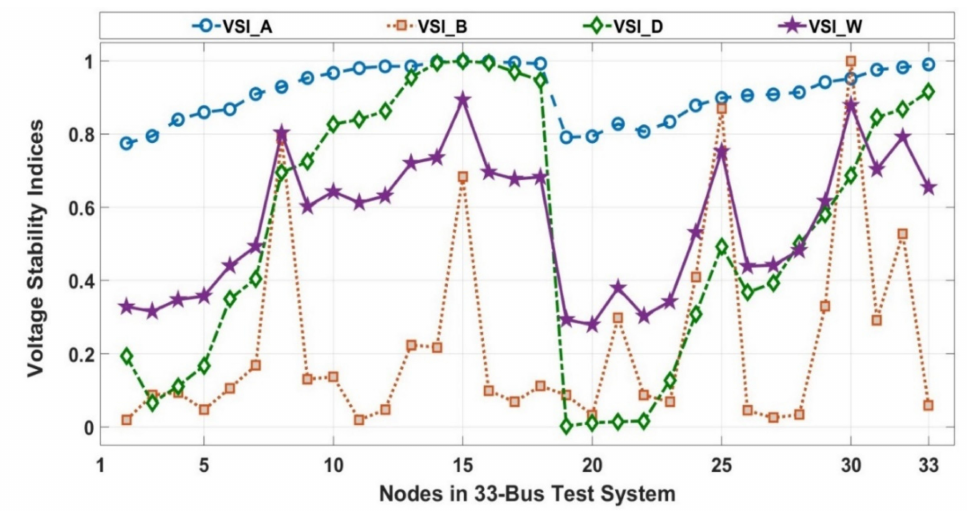
Figure 6. Various VSIs for optimal sitting locations in the 33-bus MDN. Weights were allocated in equal proportions (w = 0.333 for each VSI ) for initial eval- uation and kept equal for VSI_W with respect to Equation (4) in Figure 5. The top three weak buses as potential locations as per Figure 6 correspond to two sets of assets with two variants of VSI_A , first at buses (15, 30, 7) and later at buses (15, 30, 25). For VSI_B , the best locations for asset sitting are for buses (30, 25, 8). For VSI_D , the optimal sitting locations are (15, 32, 30). For the proposed VSI_W, the evaluated locations for asset placements correspond to buses (15, 30, 8). The respective numerical values of VSI_A are (0.7711 @ Bus